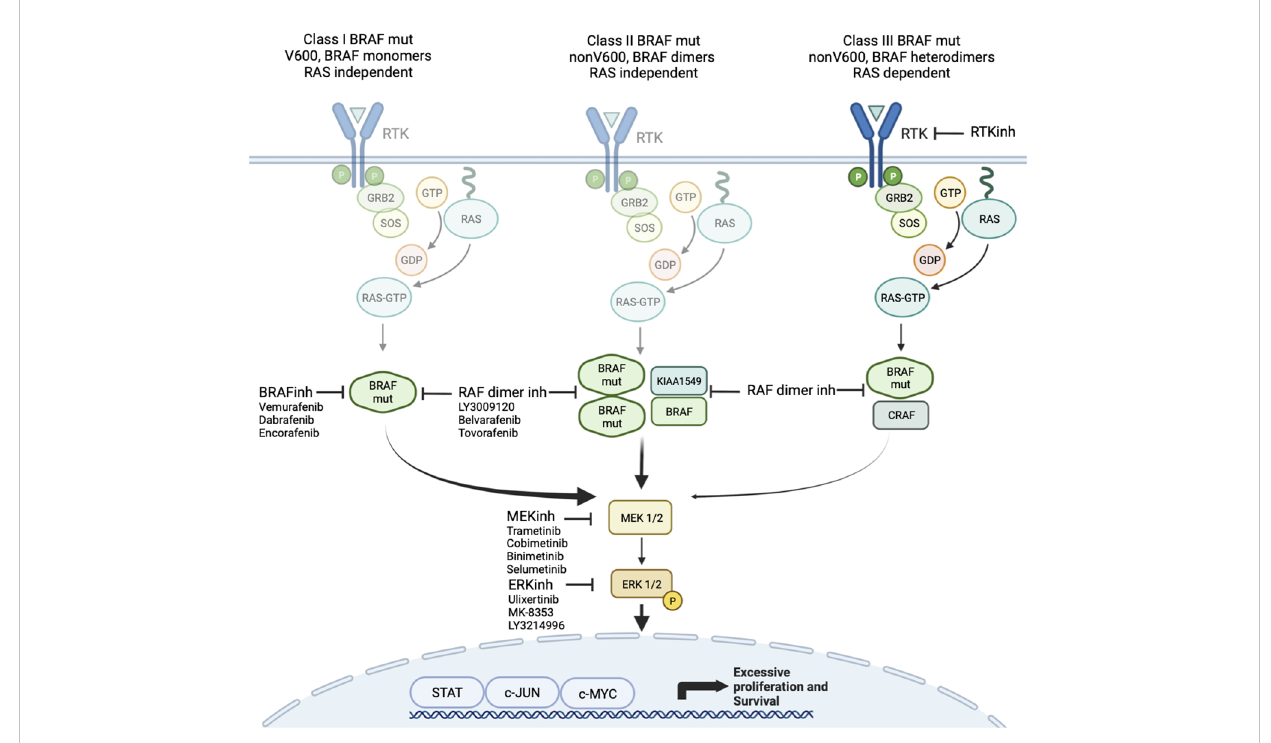
FIGURE 2 Targeted agents focused on MAPK signaling including class 1 and 2 BRAF inhibitors and MEK and ERK